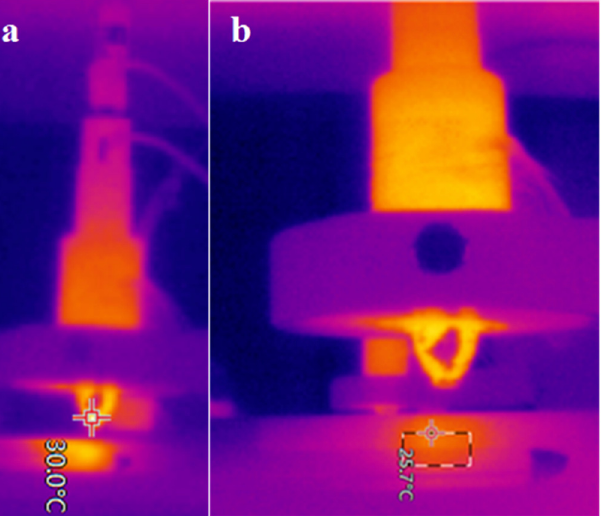
Figure 4. Thermal images of CAP torch and microwell plate. ( a ) The maximum temperature at the nozzle is 30 °C. ( b ) Assay well area measured inside the rectangle is 25.7 °C.